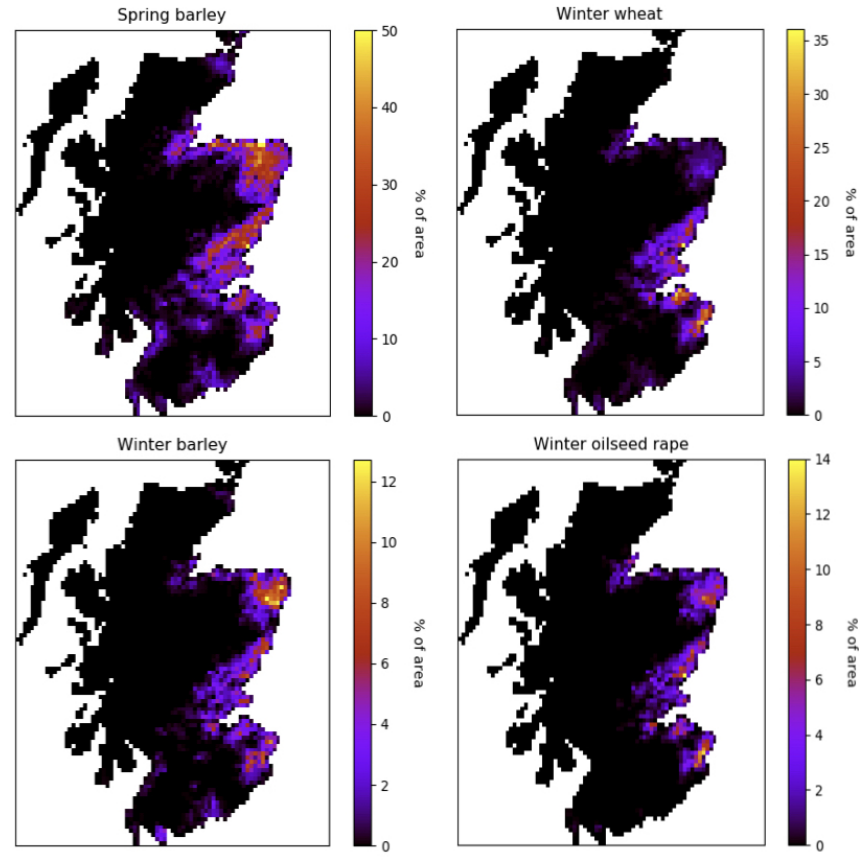
Figure 2. Percentage of area covered by each crop type in Scotland (4km 2 grid).